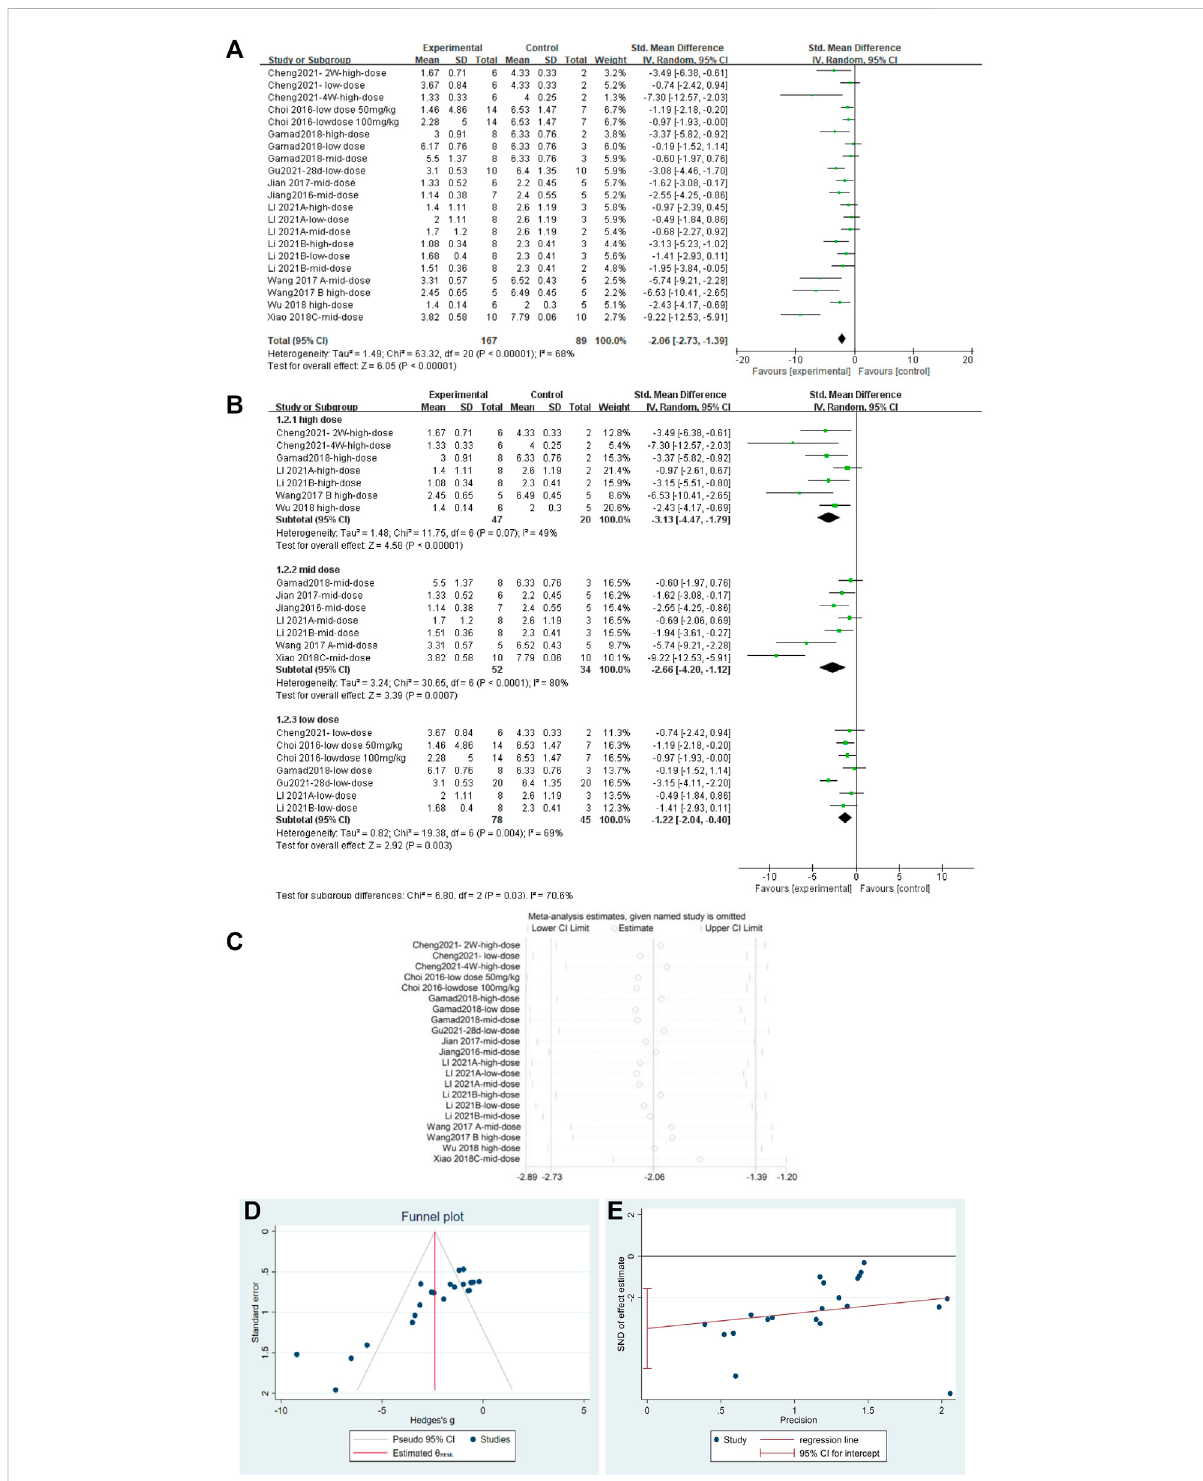
FIGURE 5 Effect of MET on fi brosis scores of lung tissues in PF animals. (A) Forest plot of fi brosis scores; (B) Forest plot of fi brosis scores (subgroups); (C) Sensitivity analysis of fi brosis scores; (D) Funnel plot of fi brosis scores; (E) Egger ’ s test for fi brosis